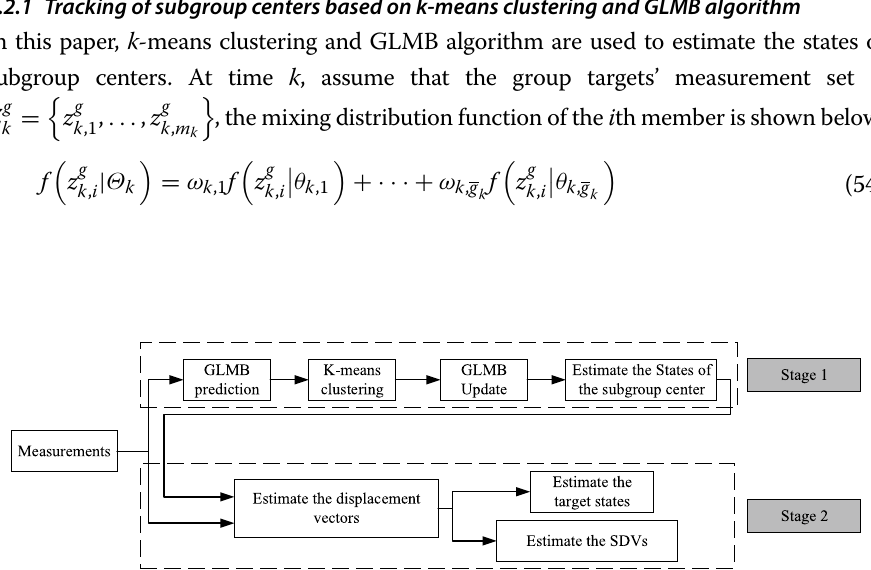
Fig. 5 Two-stage estimation